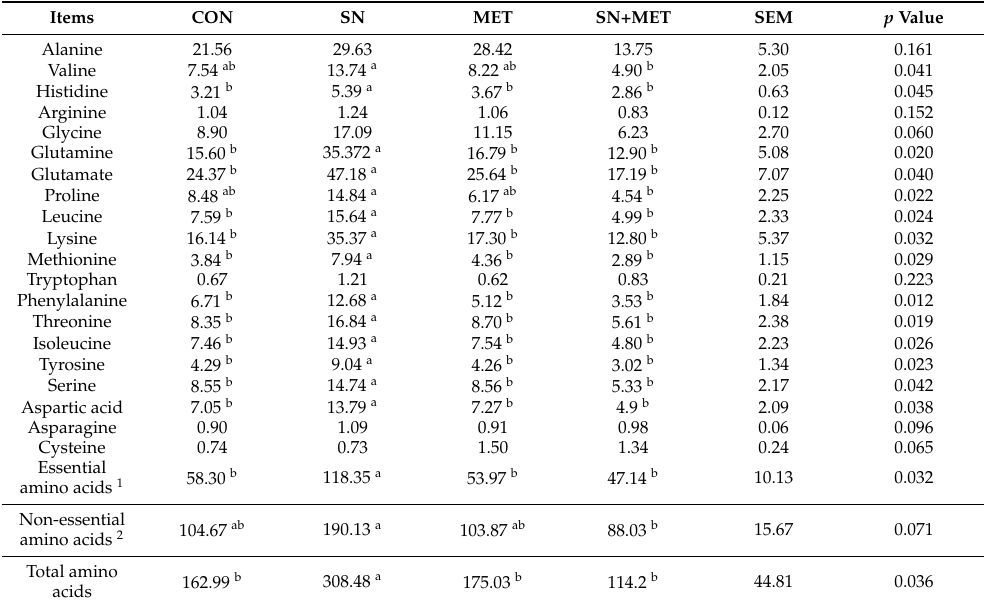
Table 4. Effects of sodium nitrate and methionine on rumen-free amino acids (N = 10) ( µ